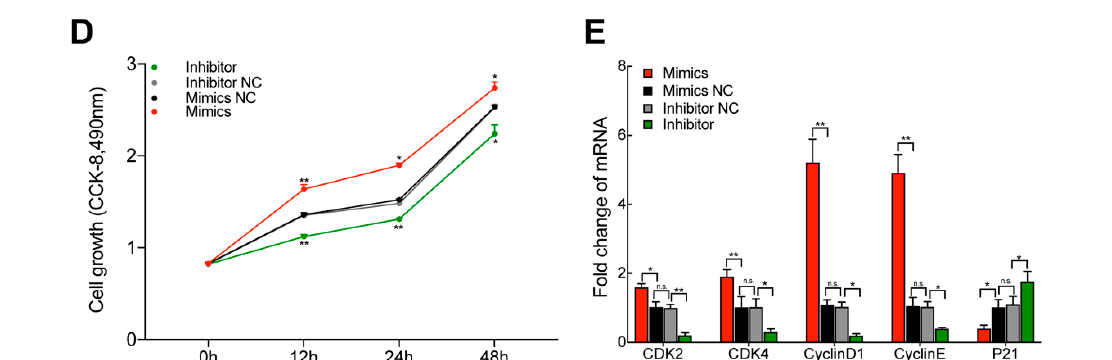
Figure 2. miR-370-3p inhibits preadipocyte proliferation. After 3T3-L1 cells were transfected with miR-370-3p mimics, inhibitors or Mimics NC and Inhibitor NC: ( A ) the transfection efficiency was measured using qRT-PCR; ( B , C ) EdU evaluated cells proliferation; ( D ) CCK-8 analysis; ( E ) the expression of genes associated with cell proliferation was measured by using qRT-PCR. Scale bars 50 µ m. All results are presented as means ± SEM. n = 3 per treatment. Each treatment represents the mean of three replicates. * p < 0.05; ** p < 0.01, n.s. no significant difference.